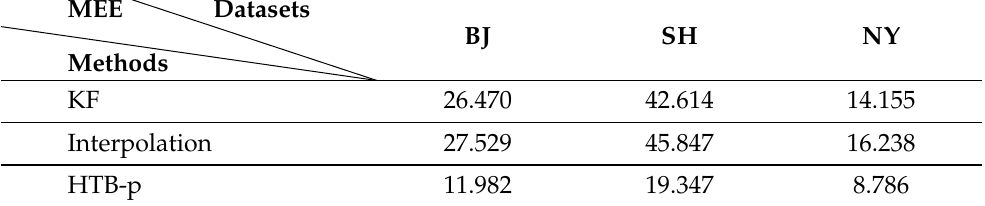
Table 3. The result of Mean Euclidean Error [m] between predicted value and actual